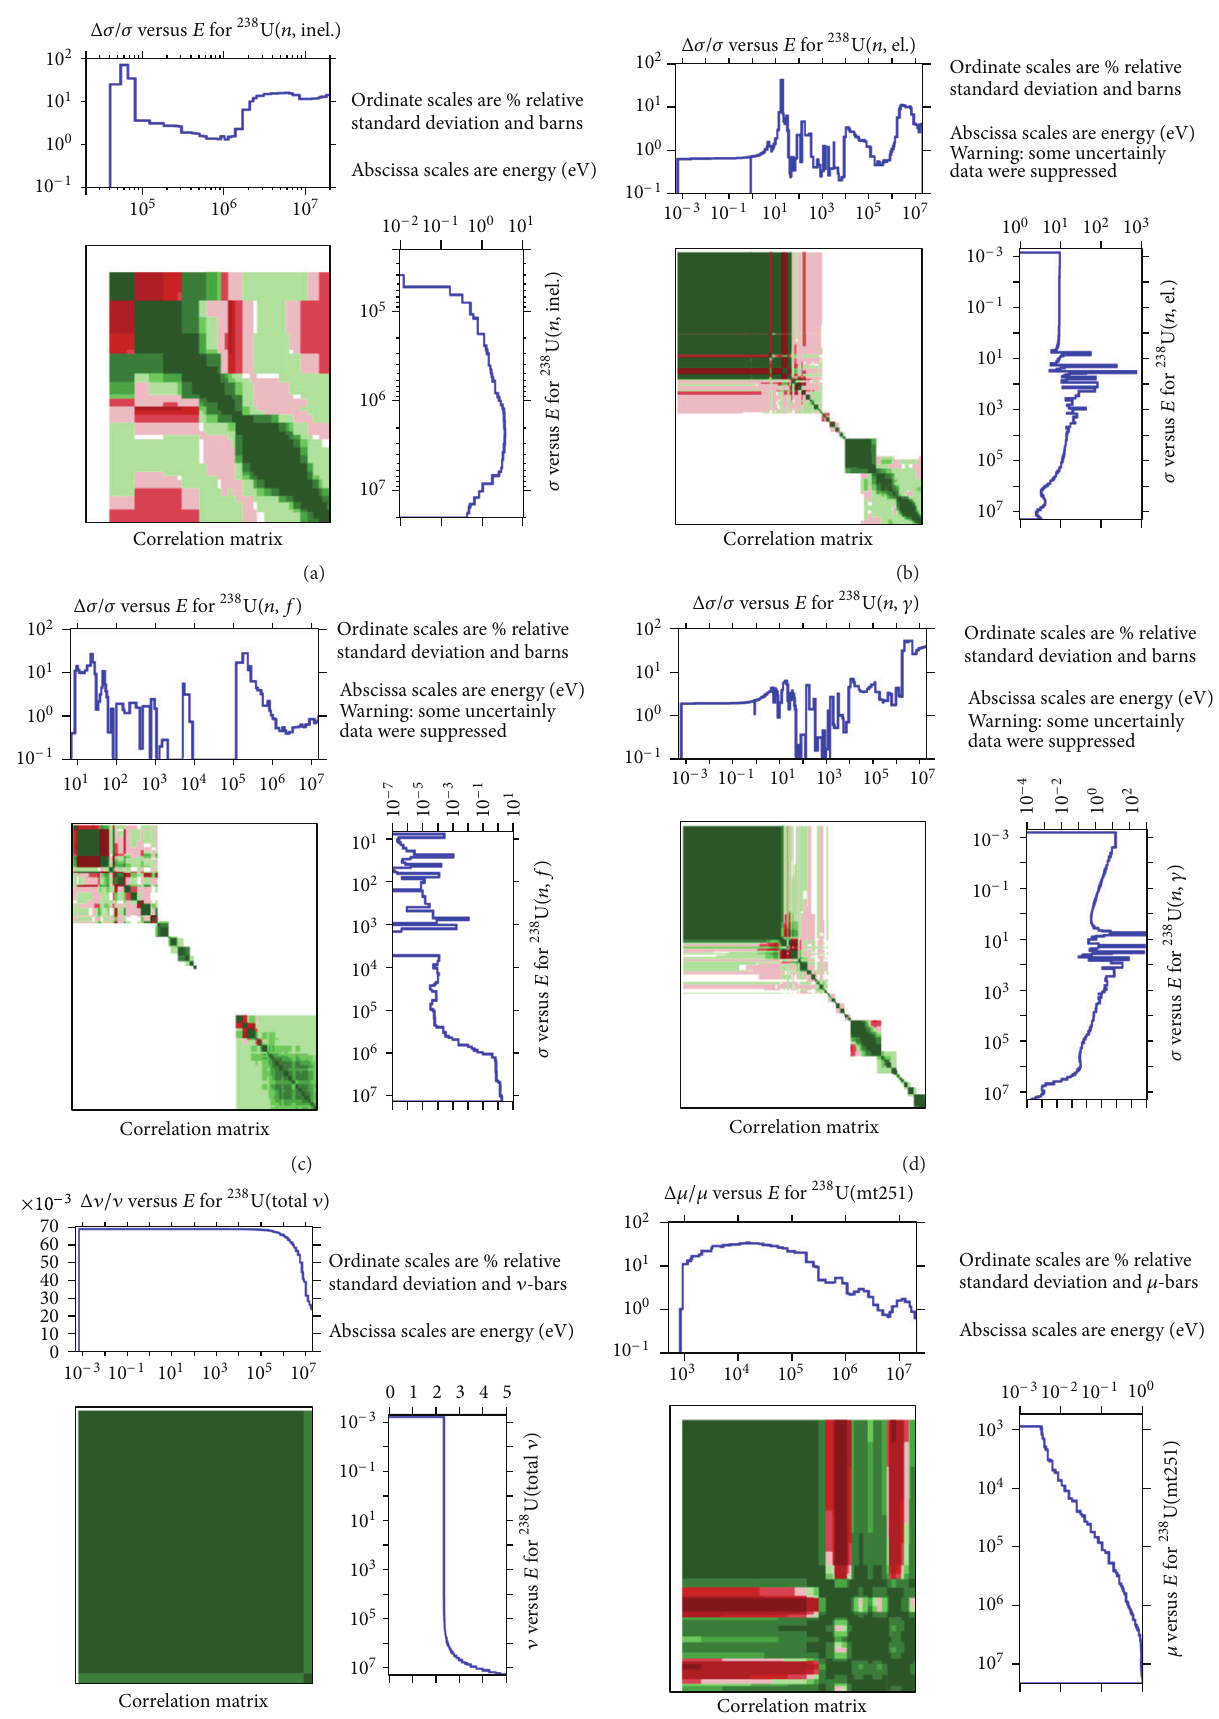
Correlation matrix